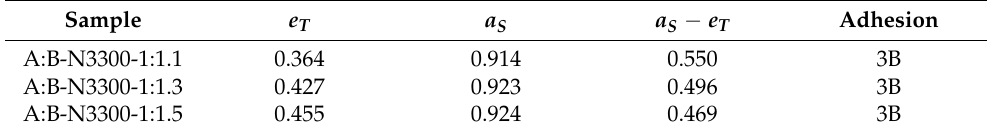
Table 1. Comparison of thermal emittance ( e T ), solar absorbance ( a S ) and adhesion to polymeric substrate of TISS coatings, prepared with the binder L200 and various concentrations of catalyst Desmodur N3300.